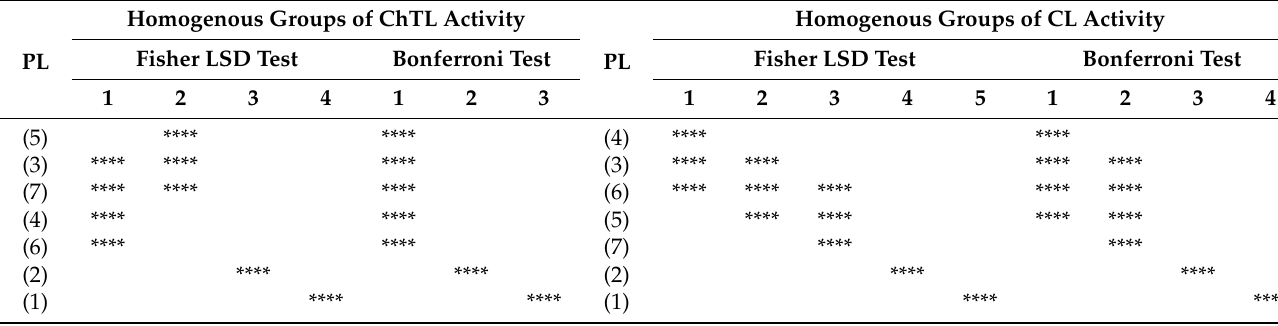
Table 3. Homogeneity of proteasome ChTL and CL activities in different intestine parts. Homogenous Groups of ChTL Activity PL